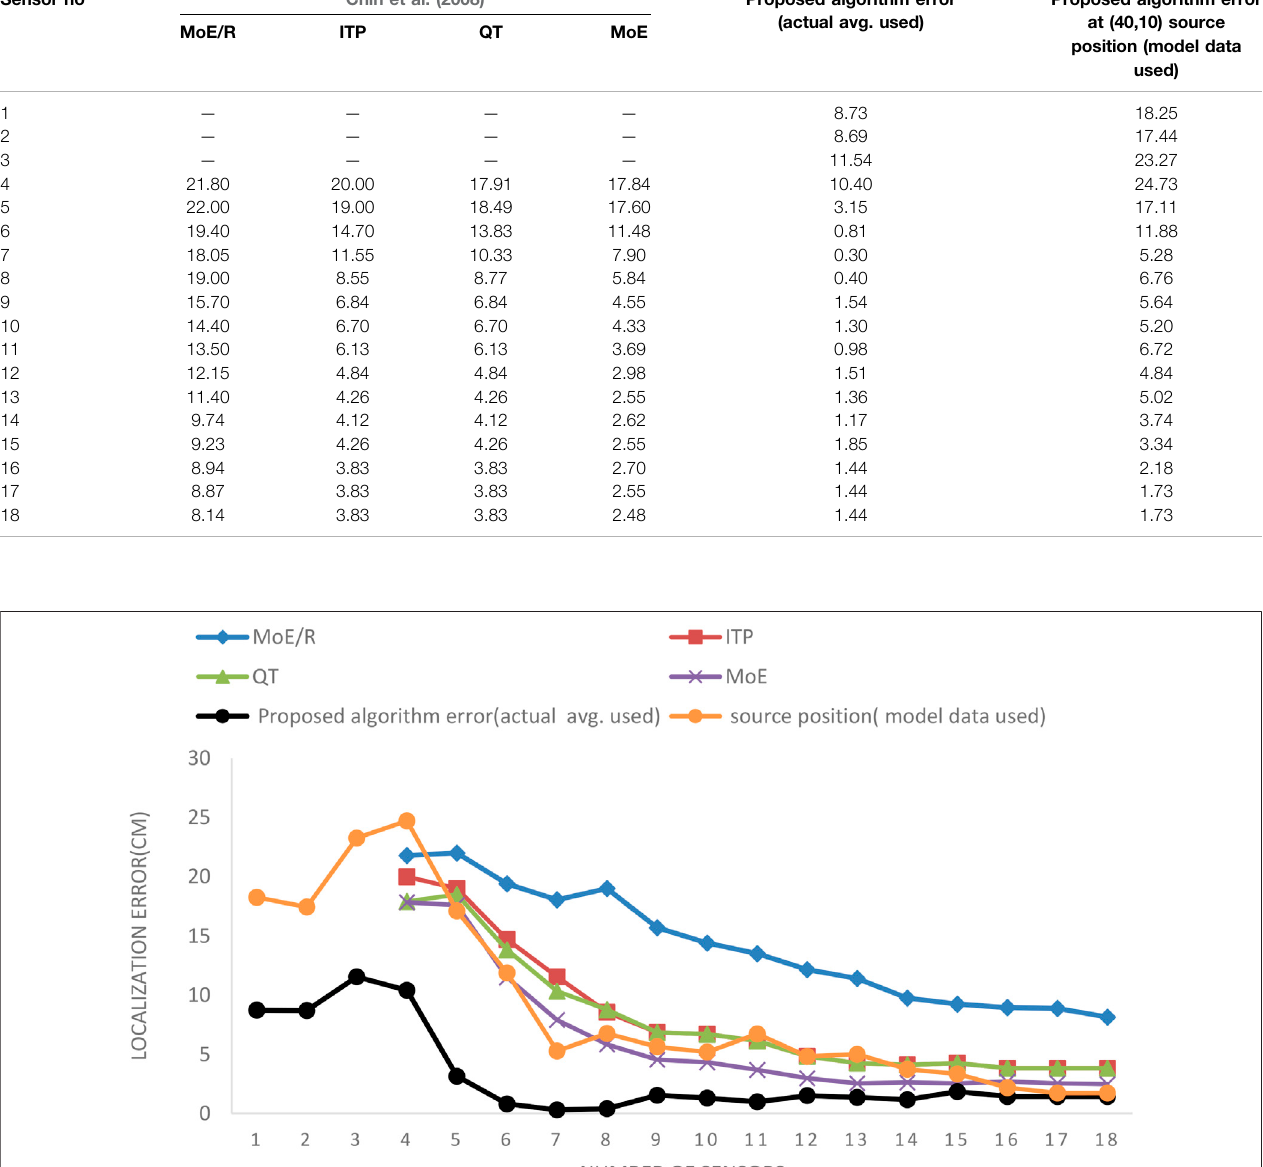
TABLE 3 | Recorded error comparison between ref. (Chin et al., 2008). and the proposed Algorithm. Sensor no Chin et al. (2008) Proposed algorithm error